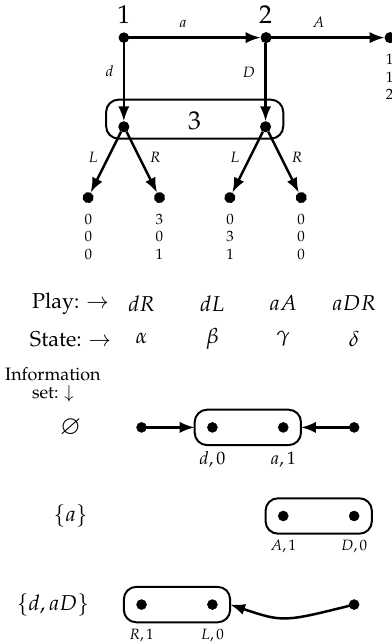
Figure 7. The game of Figure 3 and a model of